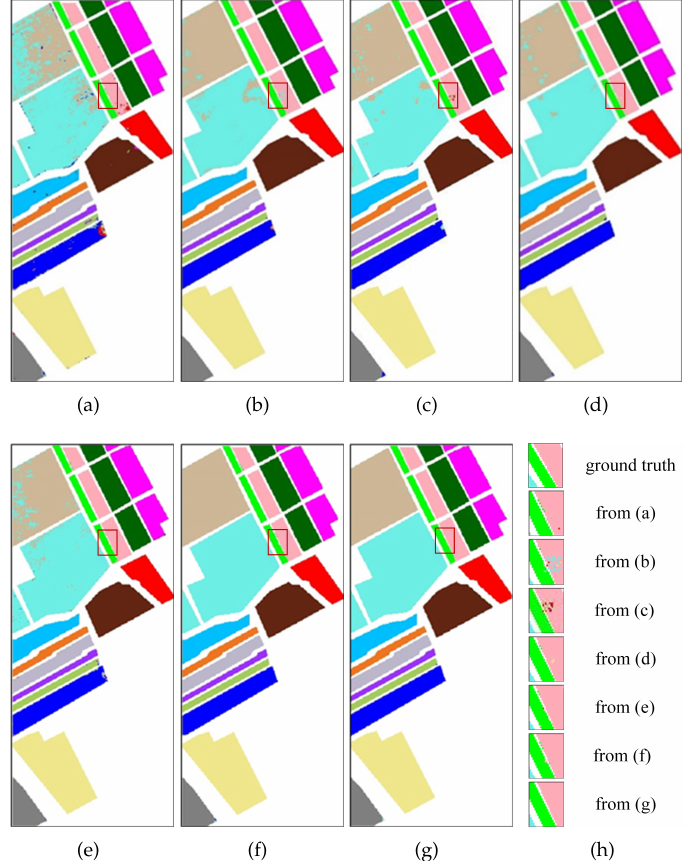
Figure 14. The classification maps of the IP dataset. ( a ) SVM. ( b ) 2D-CNN. ( c ) 3D-CNN. ( d ) HybridSN. ( e ) ViT. ( f ) SSFTT. ( g ) SDFE. ( h ) The enlarged